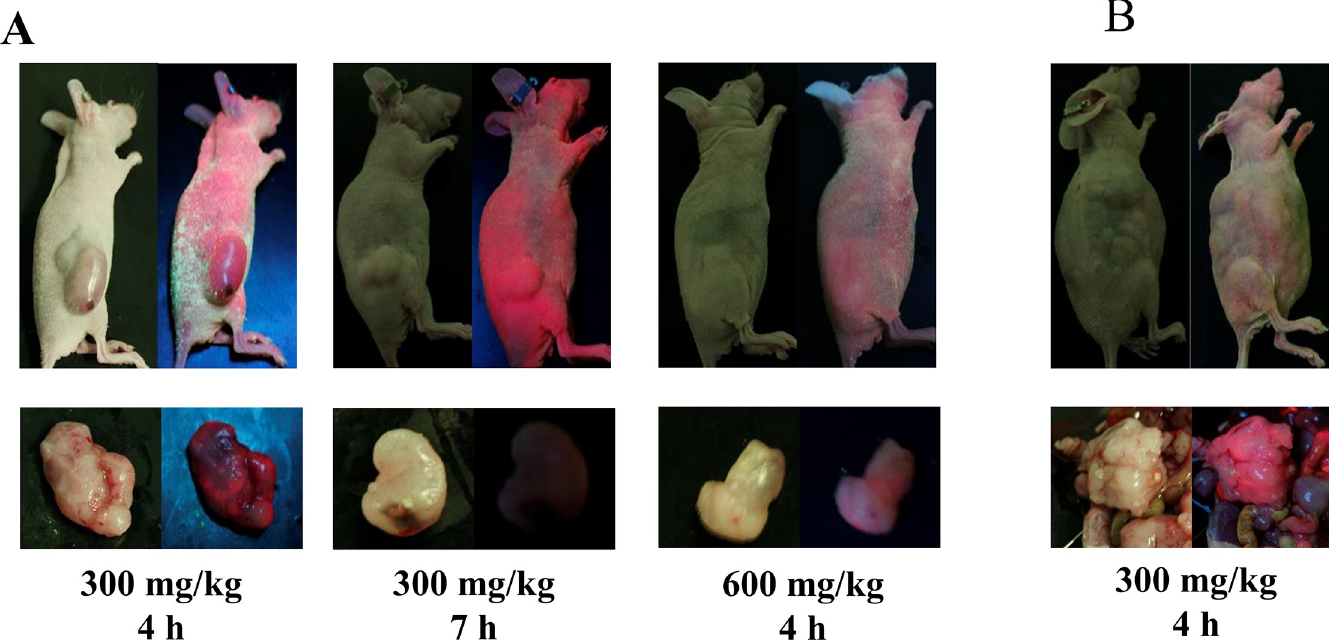
Fig 4. Fluorescent imaging of GIST xenograft models. Images were captured using a high-resolution camera equipped with an optical filter. Each image was photographed under white light (left side) and LED illumination (right side). (A) Xenograft models of flank tumors. Strong fluorescence was observed in mice receiving 300 mg/kg 5-ALA for 4 h. (B) Xenograft models of peritoneal seeding tumors. Peritoneal dissemination could not be identified through skin via LED light, but strong fluorescence was observed in extracted tumors.